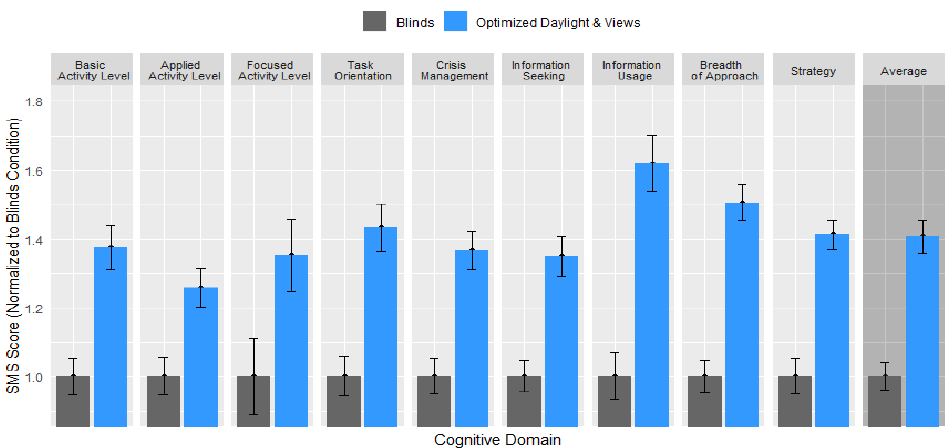
Figure 5. Cognitive scores on the Strategic Management Simulation (SMS) assessment for each of the nine domains of cognitive function, normalized to the Blinds condition.